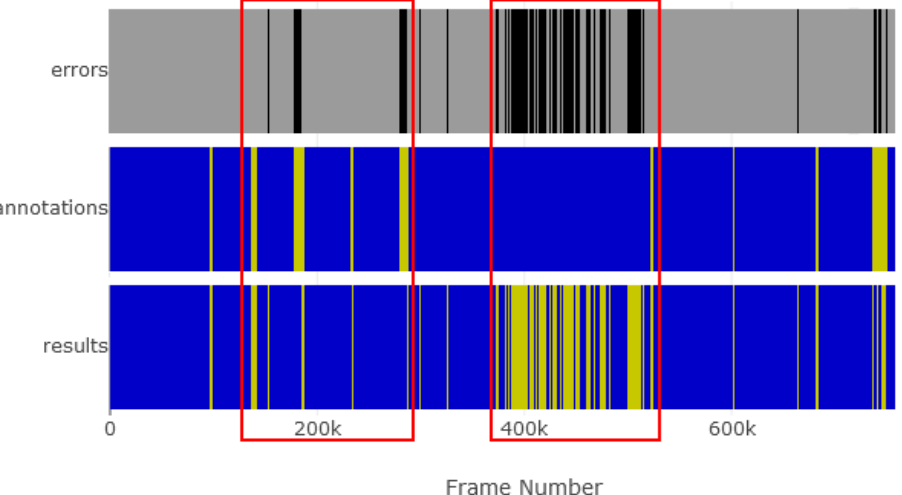
Figure 10. Comparison of the results obtained for the RTP2 stream with the annotated data, illustrated as black bars the classification errors.